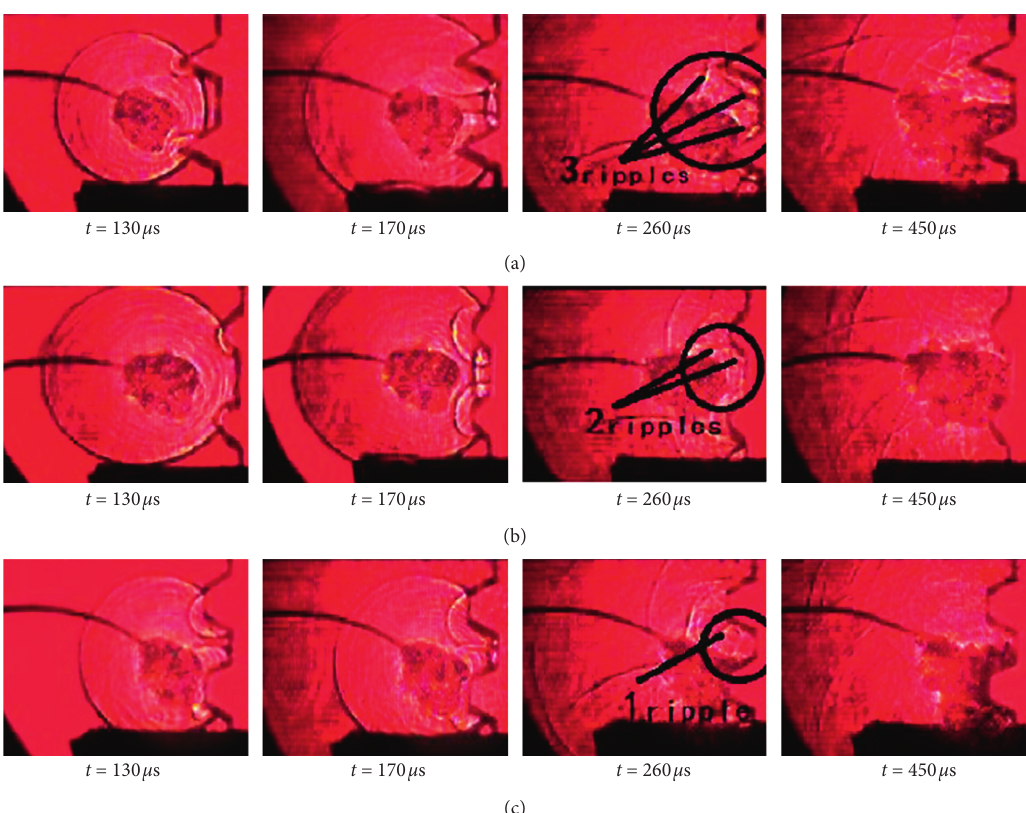
Figure 3: Reflection process of the explosion shock wave on the transverse corrugated steel plate with (a) triangular ( F ( F Y ), and (c) trapezoidal ( F T )